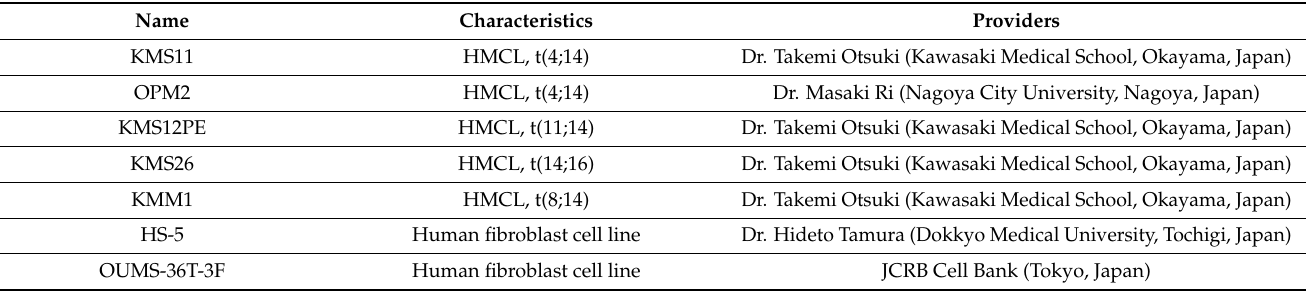
Table 1. Human myeloma cell lines (HMCLs) and human fibroblast cell lines used in the present study.